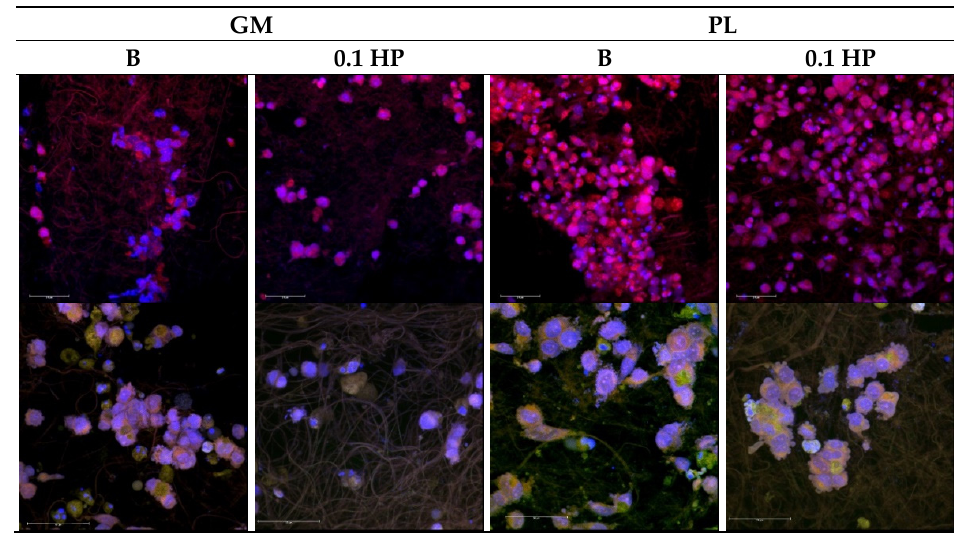
Figure 12. CLSM images of SAOS-2 grown onto the aligned scaffolds (B and 0.1 HP) after 14 days with or without platelet lysate (PL) (PL 1:20 dilution in growth medium, GM). Actin stained in red, nuclei stained in blue and sialoprotein stained in green (magnifications: 40× upper row or 63× lower row).